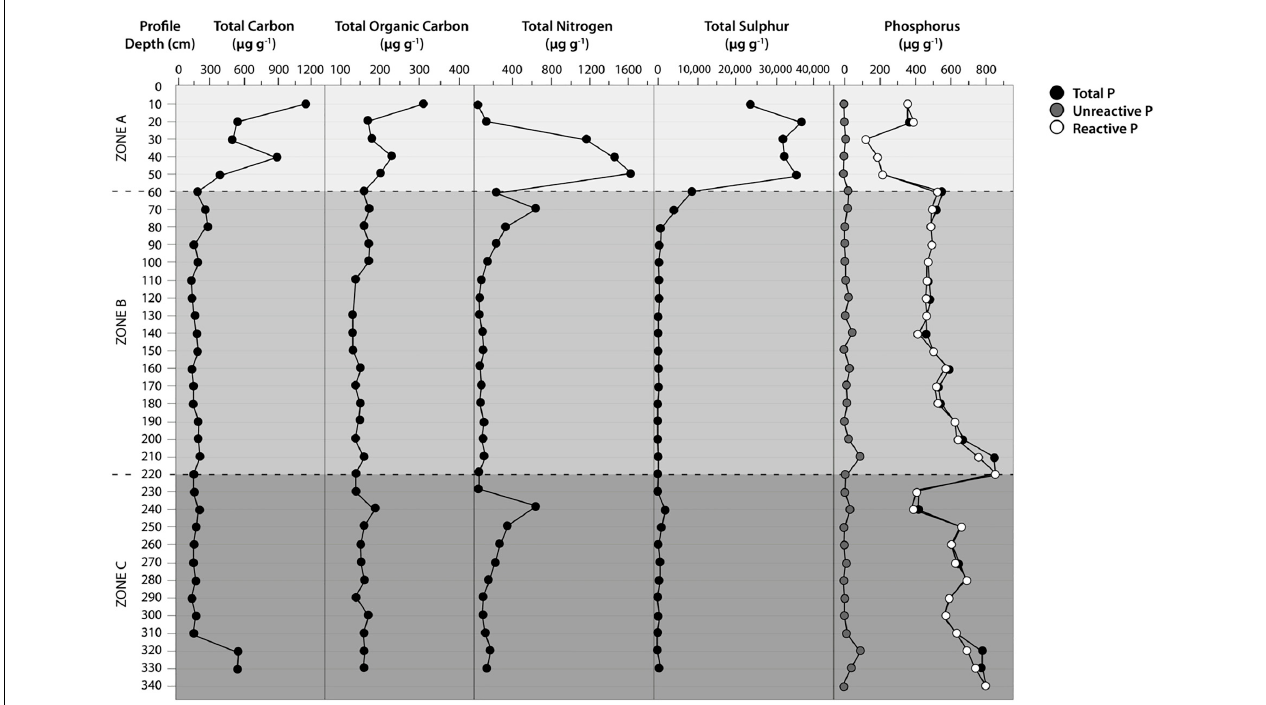
FIGURE 4 | Distribution of the soil profile parameters at the Yungay site in the hyperarid core of the Atacama Desert. Total Carbon (TC), Total Organic Carbon (TOC), Total Nitrogen (TN), Total Sulfur (TS), Total Phosphorus (TP), Reactive Phosphorus (RP), Unreactive Phosphorus (UNP).